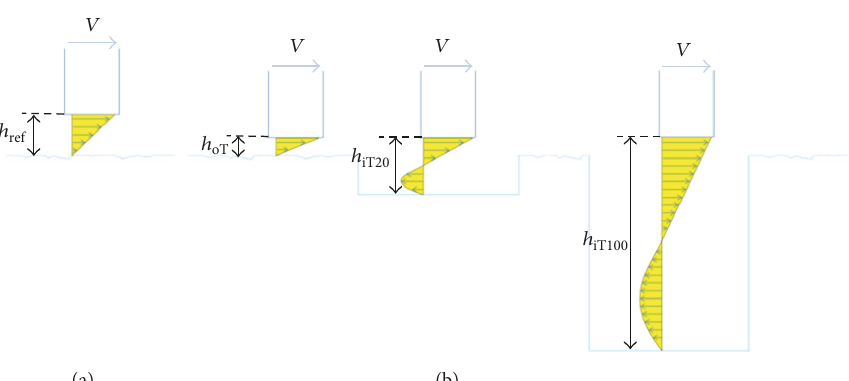
Figure 14: Schematic overview of the oil film build-up for the reference surface (a) and piston ring passage over the plateau of a textured surface; the piston ring passage over a 20 𝜇 m deep texture and the piston ring passage over a 100 𝜇 m deep texture